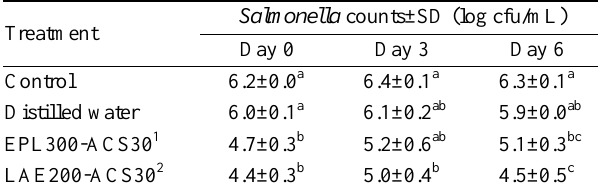
typhimurium and Salmonella enteritidis serovars on chicken carcasses sprayed with distilled water, EPL300-ACS30 or LAE200-ACS30 and stored at 4.4°C for up to 6 days